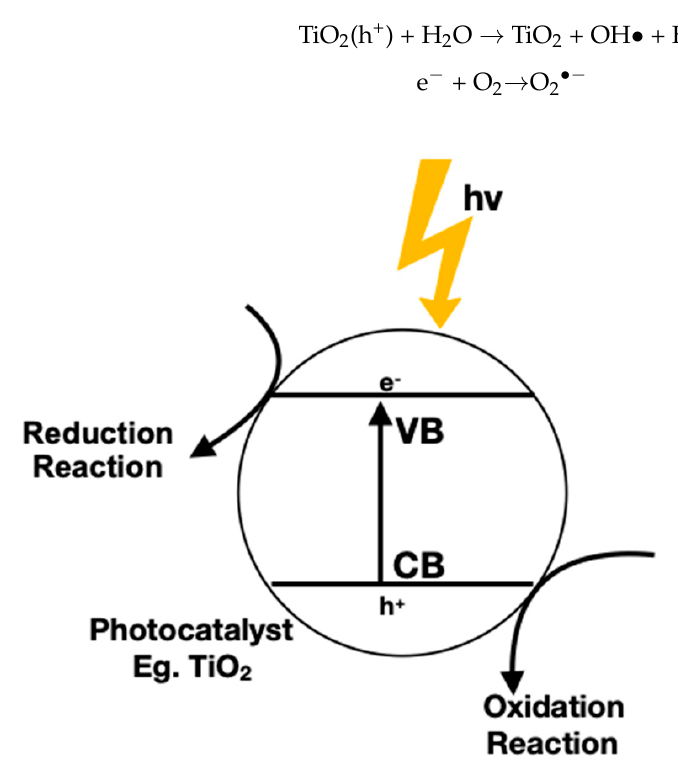
Figure 1. Simple schematic of semiconductor photo-activation showing the generation of an electron (e − ) and hole (h + ) pair when a semiconductor is irradiated with light with energy (hv) greater or equal to the semiconductor’s bandgap. Irradiation excites an electron from the conduction band (CB) to the valence band (VB).